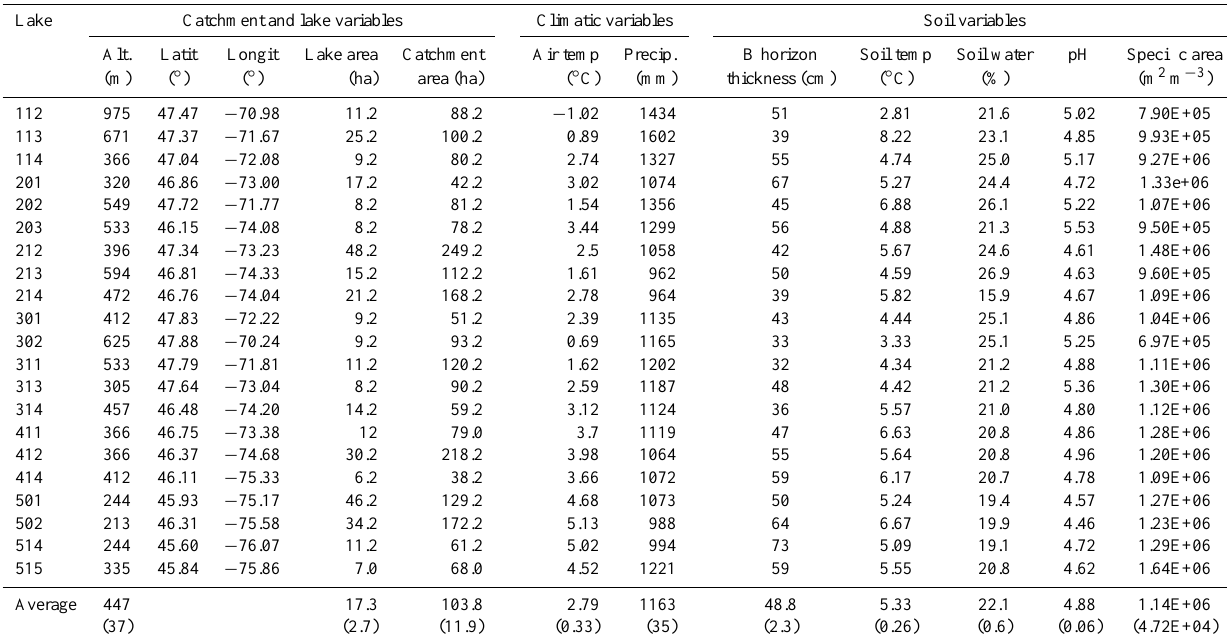
Table 1. Catchment and soil charactheristisc for the 21 sites studied. The SE for a given element of a given lake is based on 3 soil profiles per